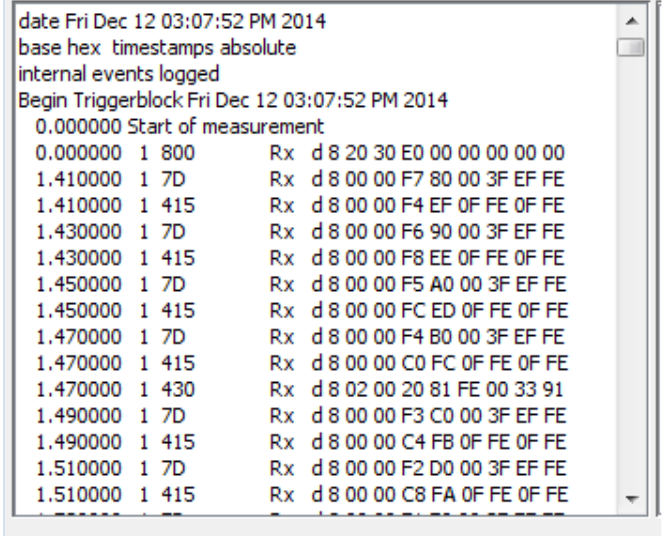
Figure 13. Example CAN messages recorded from a vehicle containing time stamp, message ID, and hexadecimal encoded data. Table 3. Example brake pad thickness measurement table.